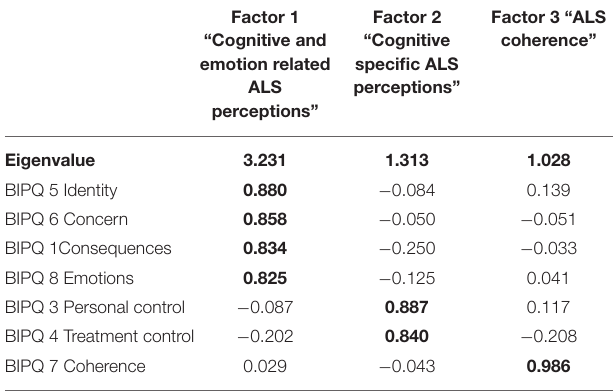
TABLE 1 | Demographic and clinical characteristics of the cohort stratified by behavioural change status.